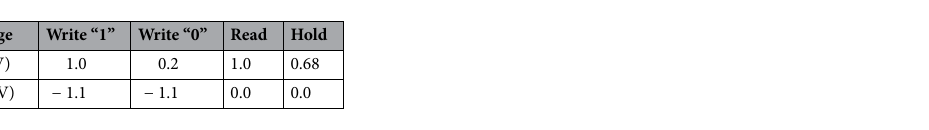
Table 1. Operating conditions of the 1T-SRAM